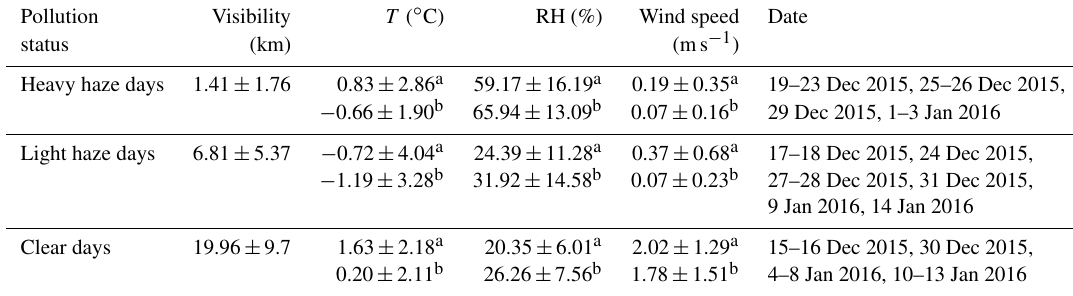
Table 1. Classification of pollution status and the corresponding meteorological conditions as well as the date.